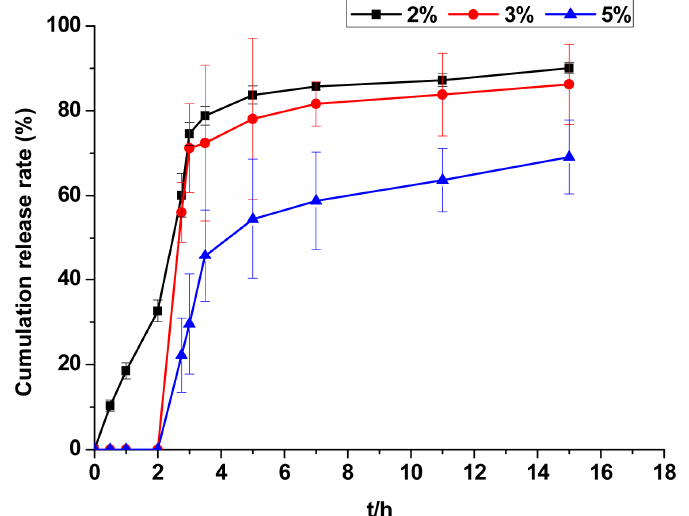
Figure 6. The effect of coating weight on the release of CAP from CCMS enteric coated tablets. Each point represents the mean ±